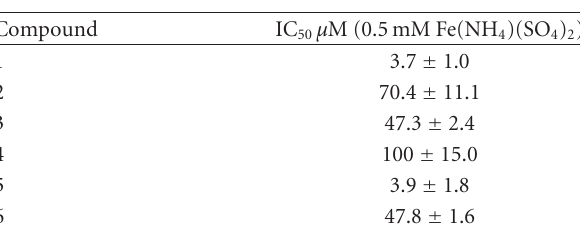
Table 1: The values of IC 50 in the antioxidative activity assay in rat brain homogenates for compounds 1 – 6